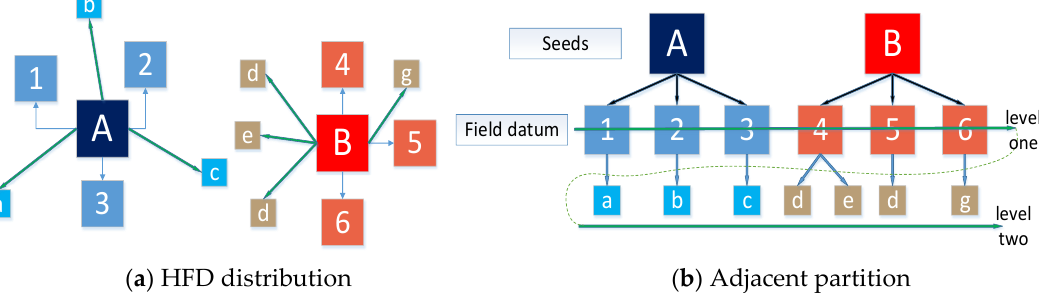
Figure 6. ( a ) Schematic of HFD distribution in two neighbouring supervoxels; ( b ) Schematic of adjacent partition and search process for supervoxels ( b ).